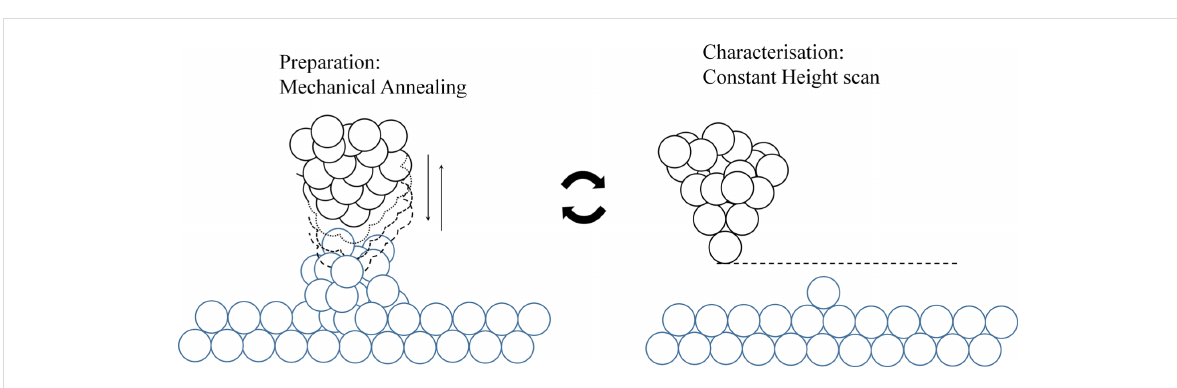
Figure 2: Schematic representation of the tip preparation process proposed in this article, where mechanical annealing cycles were followed by con- stant height scans made over a single adatom deposited on the